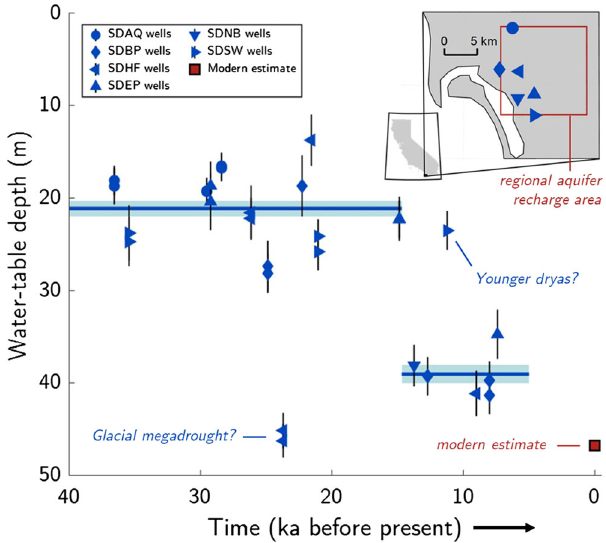
Fig. 4 Reconstructed water-table depths in the San Diego region. Noble gas isotope-derived water-table depths (WTD) from the San Diego aquifer system are presented in meters below the land surface. Blue markers and error bars (±2 σ ) indicate WTD derived from individual samples collected from wells at multiple depths at six sites (indicated by marker shapes). Pre and post 15-ka mean WTDs (lines with ±2-SE shaded regions) exclude two extreme WTD observations that could re fl ect a previously documented glacial dry period and wet Younger Dryas stadial. The present-day mean WTD over the assumed recharge area (inset) was estimated by a high- resolution, observation-constrained groundwater model (red square marker). Groundwater age uncertainties are roughly ±2 ka (Supplementary Note